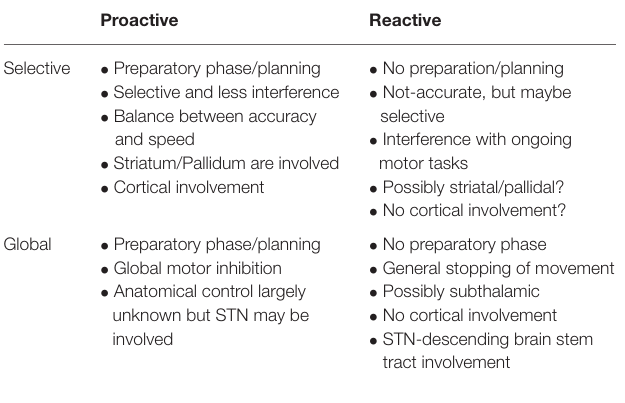
TABLE 1 | Summary of motor inhibition and the possible subcomponents including anatomical connectivity.